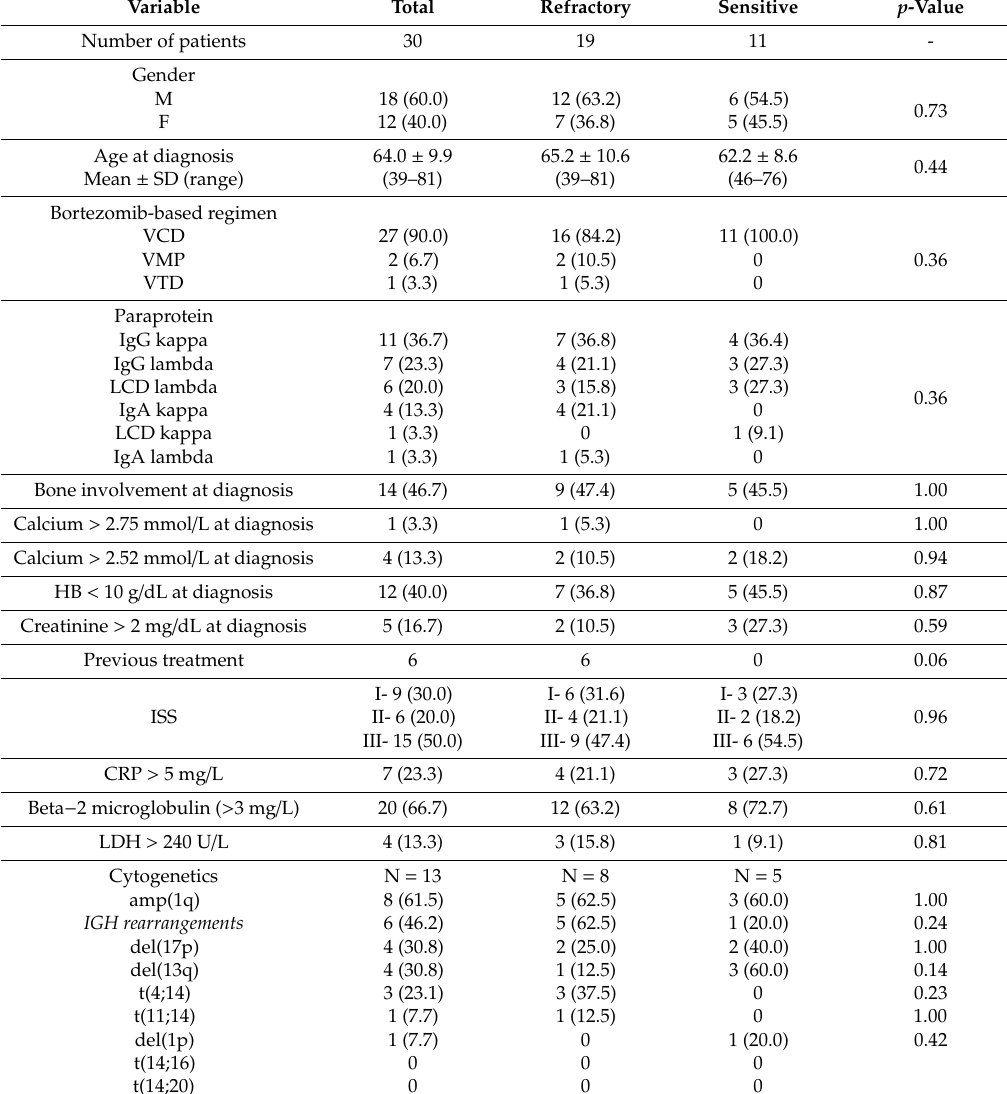
Table 1. The characteristics of the MM patients treated with Bortezomib-based therapy.